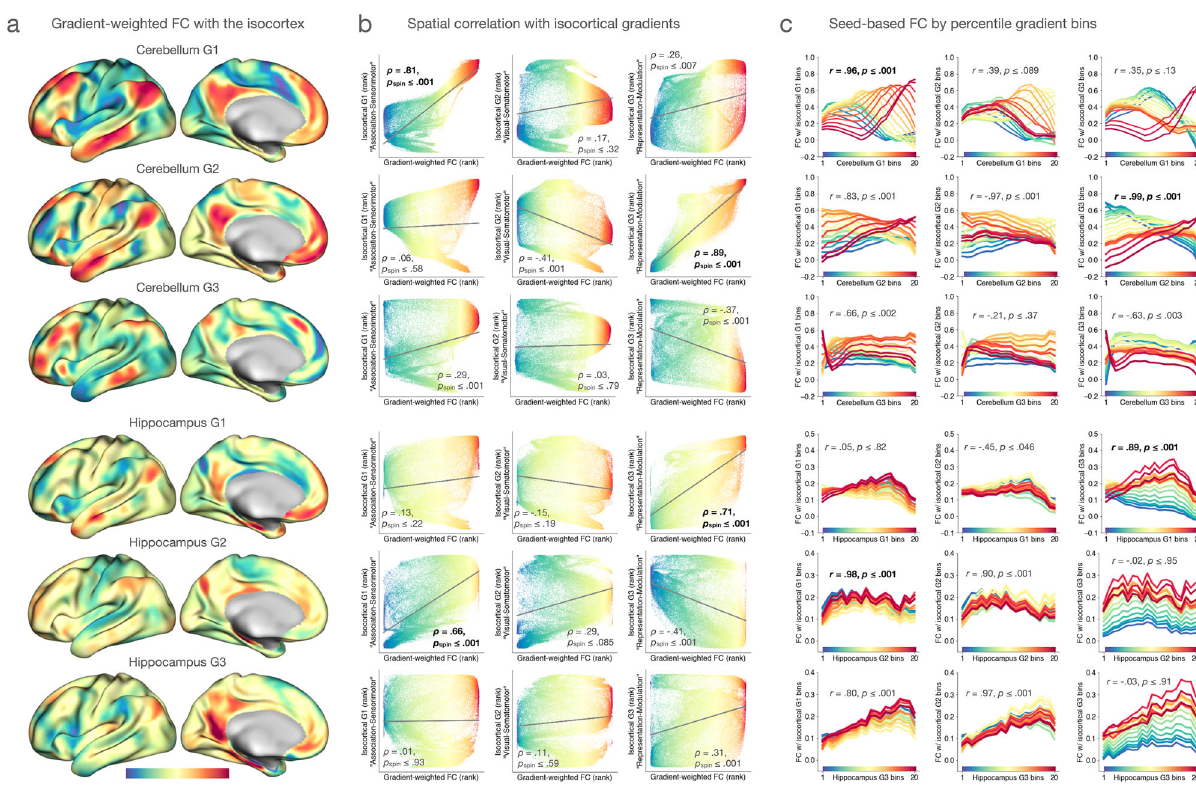
Fig. 2 Correspondence between non-isocortical and isocortical functional connectivity gradients. a Gradient-weighted functional connectivity maps were calculated by multiplying voxel-wise isocortical functional connectivity maps of the cerebellum (or hippocampus) by cerebellar (or hippocampal) connectivity gradient values. The resulting surface maps thus characterize the topography of the isocortical functional connectivity variation that each non- isocortical gradient represents. b Spatial correspondence between each pair of a gradient-weighted connectivity map and an isocortical connectivity gradient was assessed by Spearman ’ s rank correlation; p values were computed while controlling for spatial autocorrelation via spin permutation tests 60 . c Based on the percentile ranks associated with voxel-wise gradient values, each non-isocortical and isocortical gradient was discretized into 20 spatially non-overlapping bins. These bins were used to compute functional connectivity between each unique pairwise combination of gradient bins across structures. For each non-isocortical gradient bin, Pearson ’ s correlation coef fi cient was calculated between isocortical gradient bin indices (1 – 20) and functional connectivity values associated with them, thus yielding a single correlation coef fi cient per non-isocortical bin. In the next step, Pearson ’ s correlation coef fi cient was calculated between non-isocortical gradient bin indices (1 – 20) and these isocortical correlation coef fi cients. This procedure, therefore, resulted in one correlation coef fi cient for each pair of non-isocortical and isocortical gradients, shown here in each panel, representing the extent to which these gradients correspond to one another in terms of functional connectivity. All p values are based on two-sided hypothesis testing. For each non-isocortical gradient, the strongest correlation is shown in bold